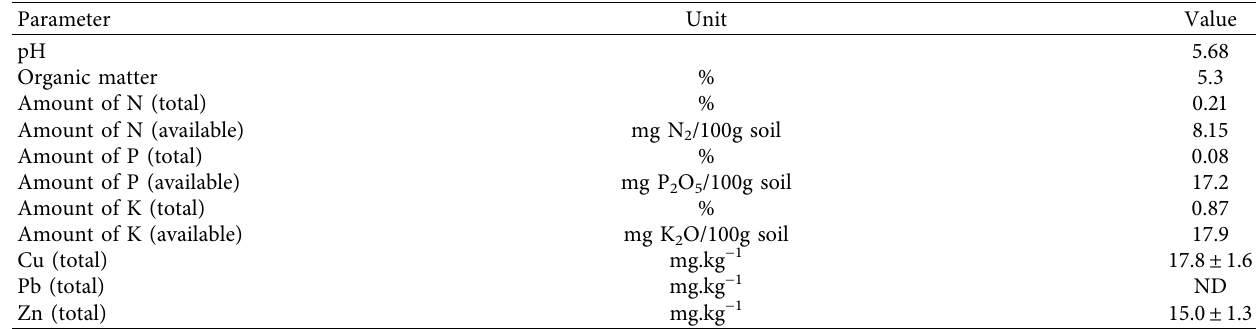
Table 2: The physical and chemical properties of soil studied.